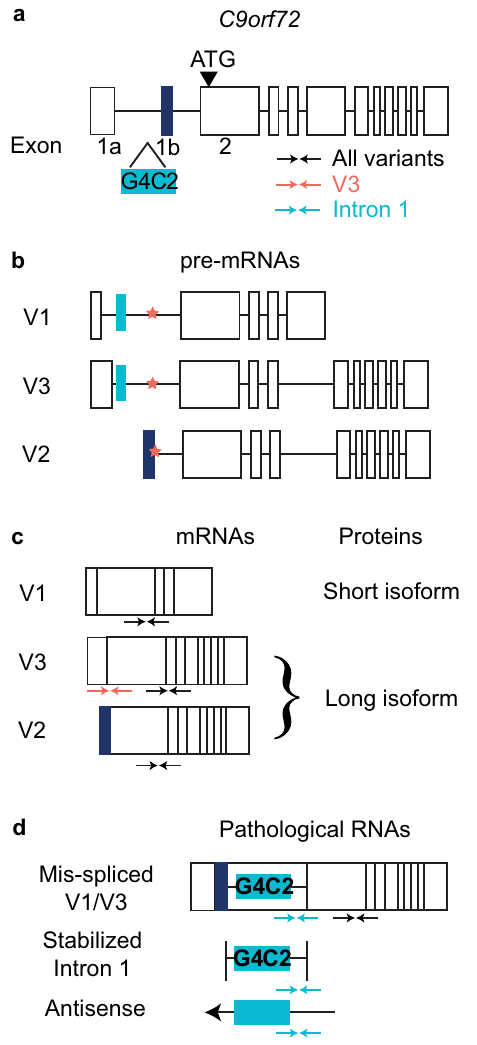
Fig. 1 Schematic representation of C9orf72 gene structure, RNA, and protein products, and the strategy for detecting C9orf72 transcripts. a C9orf72 genomic structure is illustrated; boxes represent exons. Exon 1a and 1b (navy), which do not encode protein, are alternative fi rst exons, and exon 2 contains the translational start site (ATG, black triangle). The G 4 C 2 - repeat expansion (aqua) is in intron 1, upstream of exon 1b. Approximate position of primers used to detect various transcripts in Taqman assays are illustrated with arrows, including primers that span the exon 2 – exon 3 junction (black) that detects all transcripts, primers that span the exon 1a – exon 2 junction (coral) that are speci fi c to V3, and primers complementary to intron 1 (aqua) that detect all intron 1-containing and expansion-containing variants. b pre-mRNAs corresponding to V1 – V3 are illustrated. The coral star indicates SS1b. c Mature mRNAs for all variants and the proteins they encode are shown. Primers for all variants detect all three mature mRNAs, whereas the V3 primers are speci fi c to V3. Intron 1 primers do not detect any mature mRNAs. d Pathogenic RNA by-products resulting from the G 4 C 2 -repeat expansion in intron 1 are shown. The location of the G 4 C 2 -repeat expansion (aqua) is shown in sense and antisense RNAs. Intron 1 primers detect all pathological RNAs, and the all variants primers will detect any mis-spliced V1/V3 transcripts that include exon 2. SS1b Splice site 1b, V